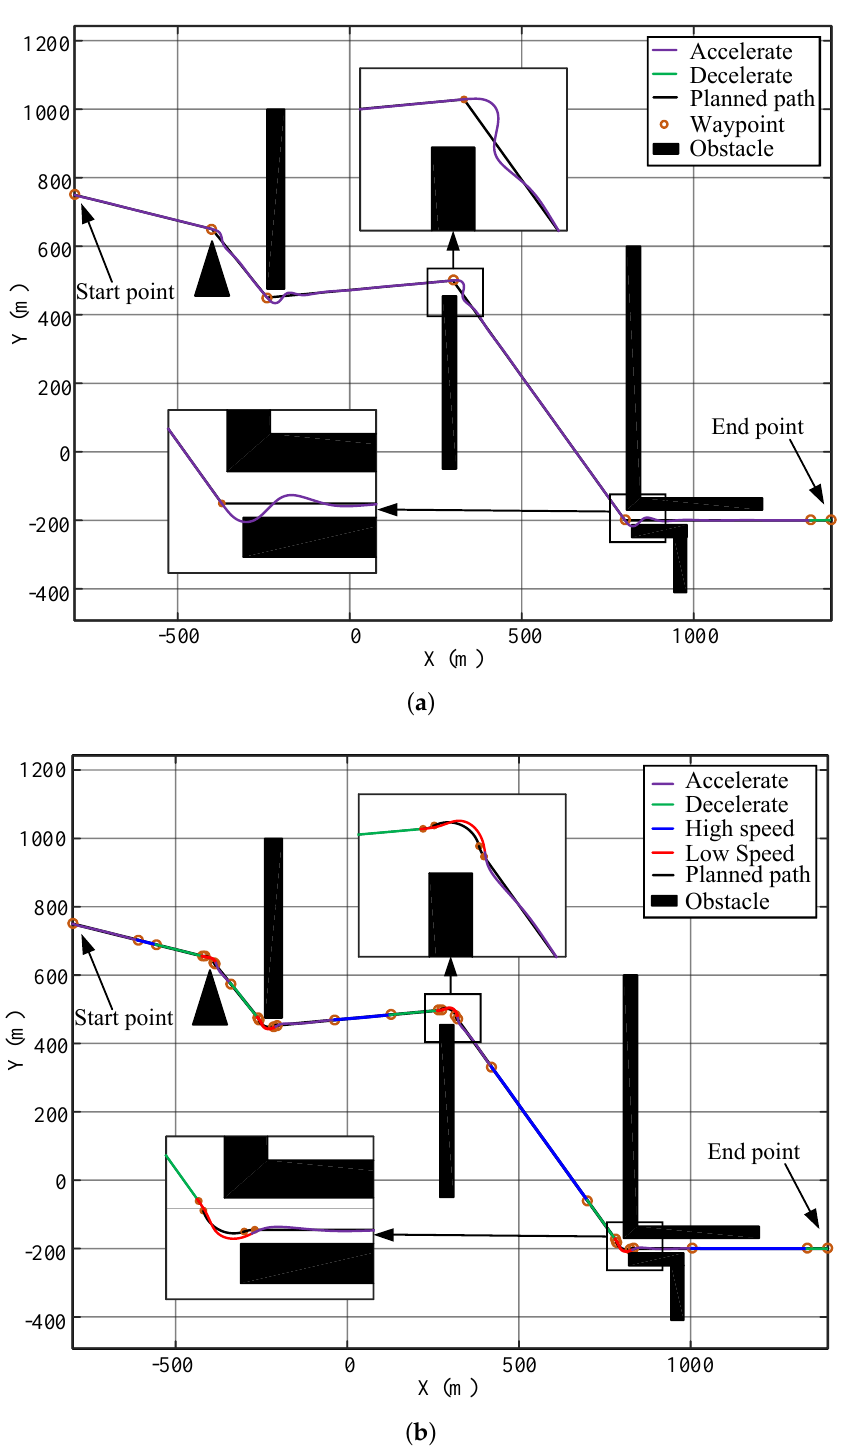
Figure 14. Simulation of the small-angle turning tracking scene: ( a ) Original path-tracing results. ( b ) Optimized path-tracing